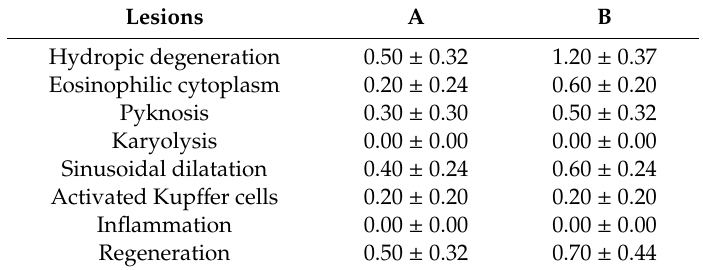
Table 5. Liver lesion scores (mean ± SEM) for female ICR mice in acute toxicity study of CELE.